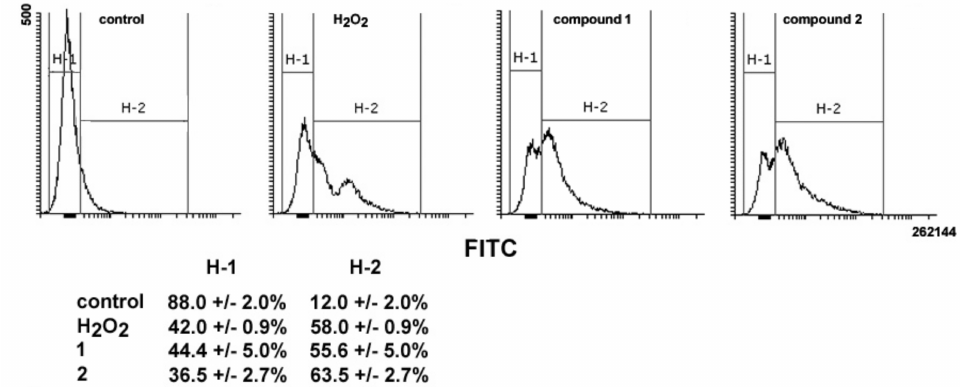
Figure 8. Representative histograms showing ROS generation in MDA-MB-231 cells cultured in control conditions or exposed to either H 2 O 2 (as a positive control), 1 , or 2 for 24 h. The x-axis reports the intensity of green fluorescence emitted by the dye 2’,7’-dichlorodihydrofluorescein, which is proportional to the amount of cytosolic ROS. The fluorescence percentages of the gated regions H-1 and H-2 of the histograms are reported under the graphs. The results are expressed as the mean ± SEM of triplicate